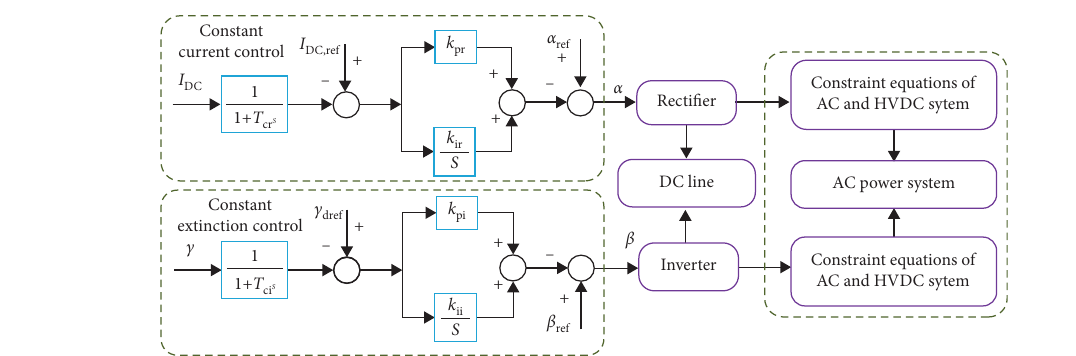
Figure 2: HVDC transmission system.